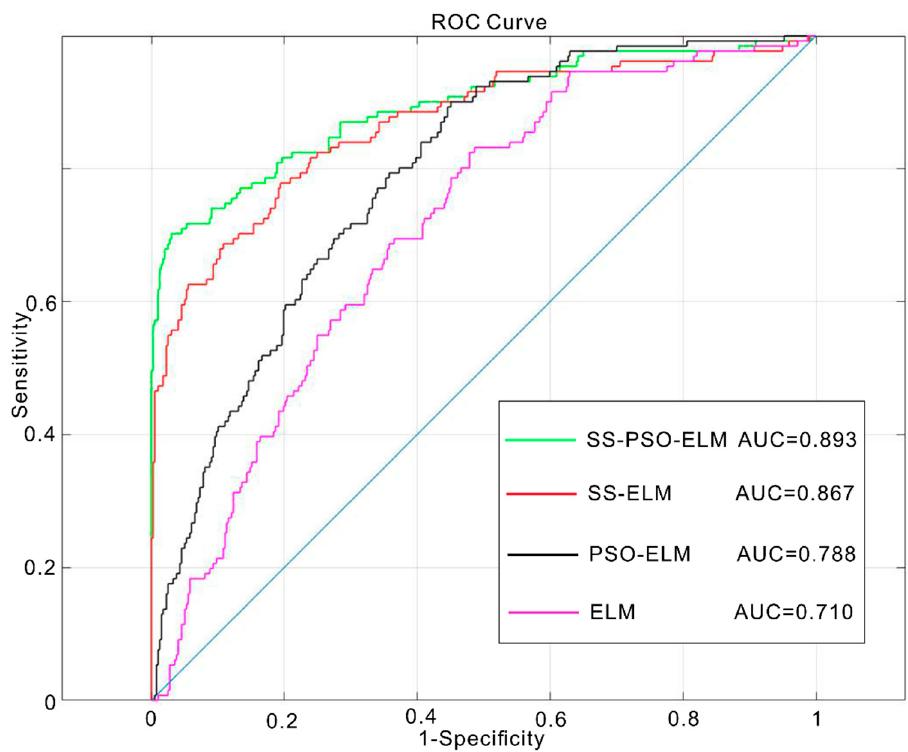
Figure 11. ROC accuracy